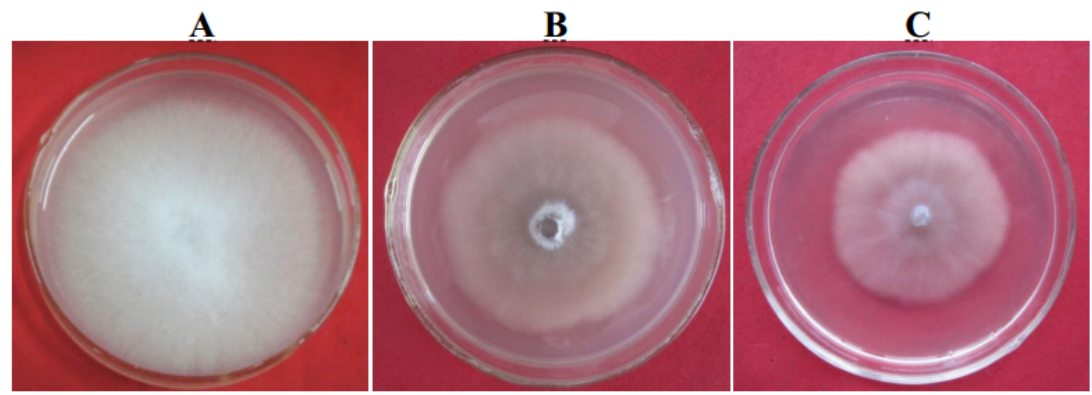
Figure 7. Morphology growth characterization of pgc4 gene knock-out mutants. ( A ): Foc4; ( B ): Foc4 ∆ pgc4 ; ( C ): Foc4 ∆ pgc4 + pgc4 .